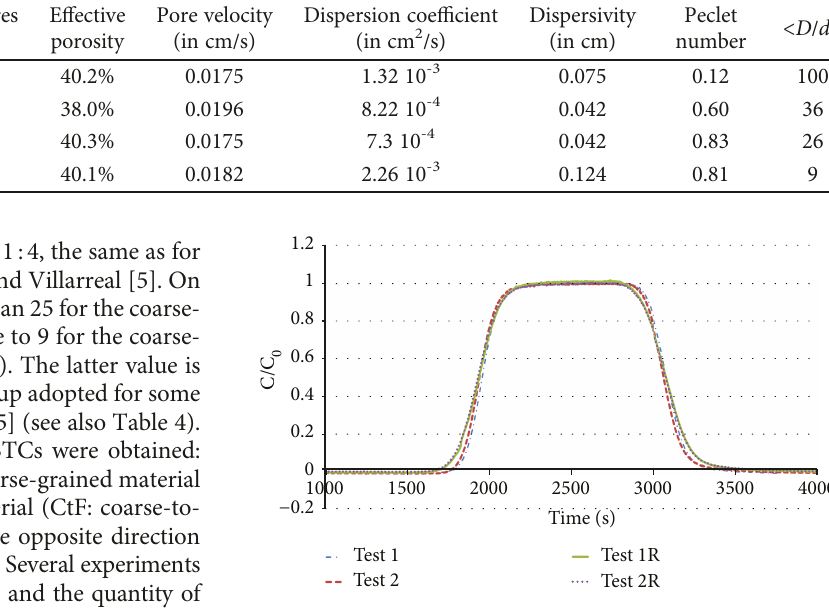
Figure 2: Breakthrough curves of experiments with a homogeneous column — 300-400 μ m beads. Flow rate = 0 27 mL/min. Test 1 and 2: direct tests; test 1R and 2R: reversed column